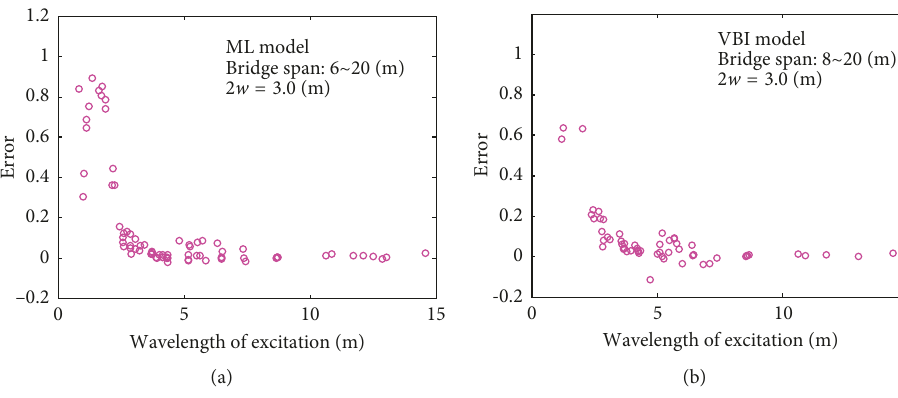
Figure 16: Reduction coefficient from load spreading. (a) ML model. (b) VBI model.